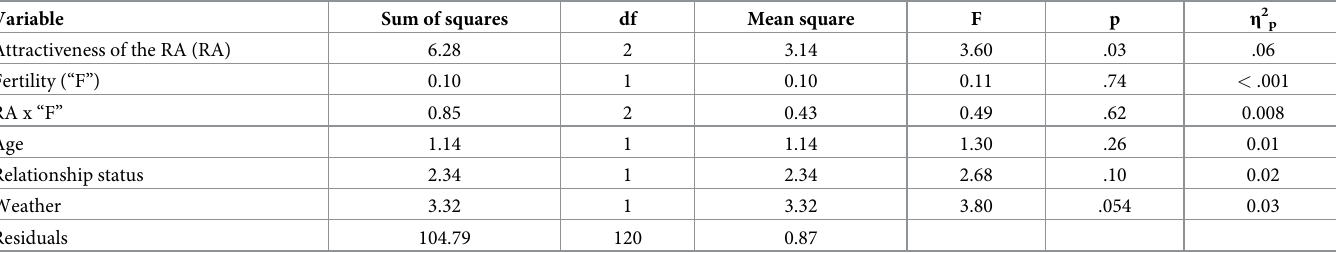
Table 5. The effects of the attractiveness of the research assistant, “fertility”, research assistant x “fertility” interaction, controlling for age, relationship status, and weather. Variable Sum of squares Attractiveness of the RA